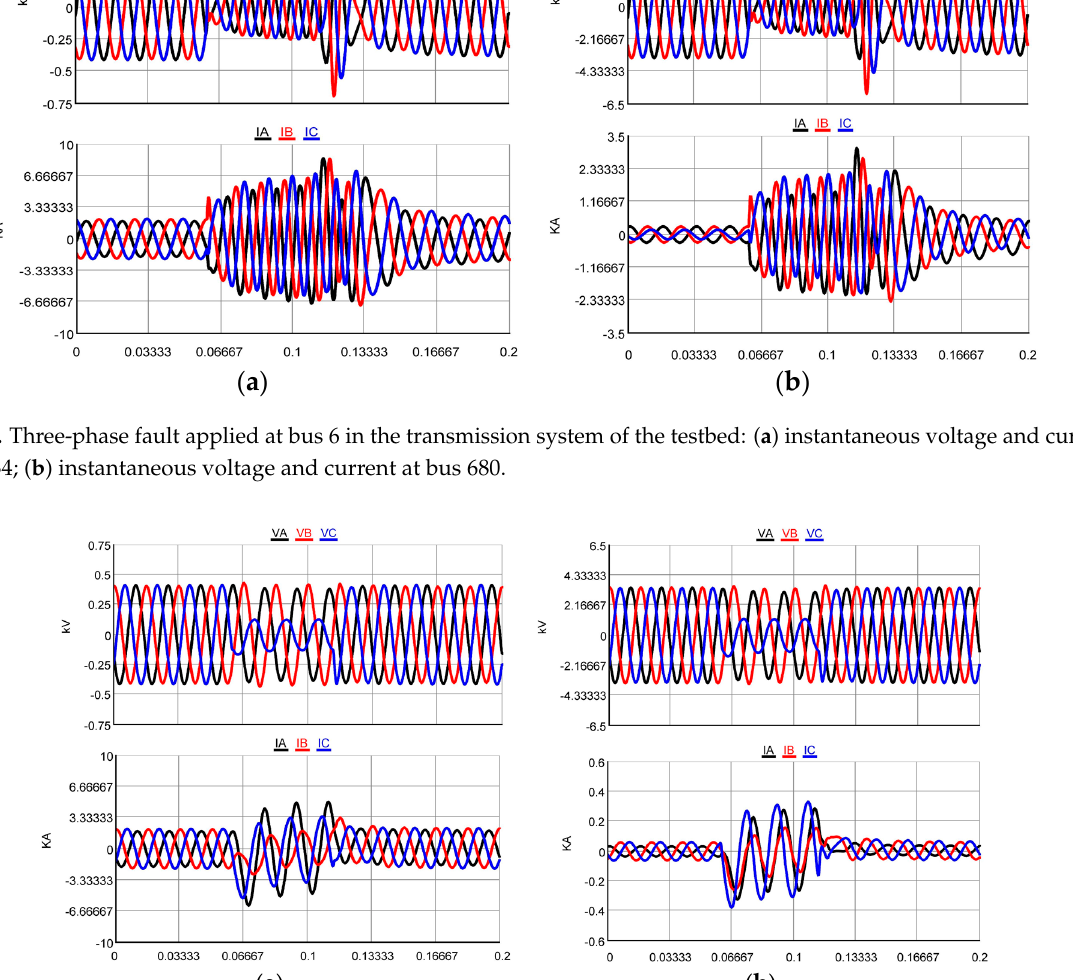
( b ) Figure 10. Line-to-line fault applied at bus 6 in the transmission system of the testbed: ( a ) instanta- neous voltage and current at bus 634; ( b ) instantaneous voltage and current at bus 680. ( a ) ( b ) Figure 11. Double line-to-ground fault applied at bus 6 in the transmission system of the testbed: ( a ) instantaneous voltage and current at bus 634; ( b ) instantaneous voltage and current at bus 680.